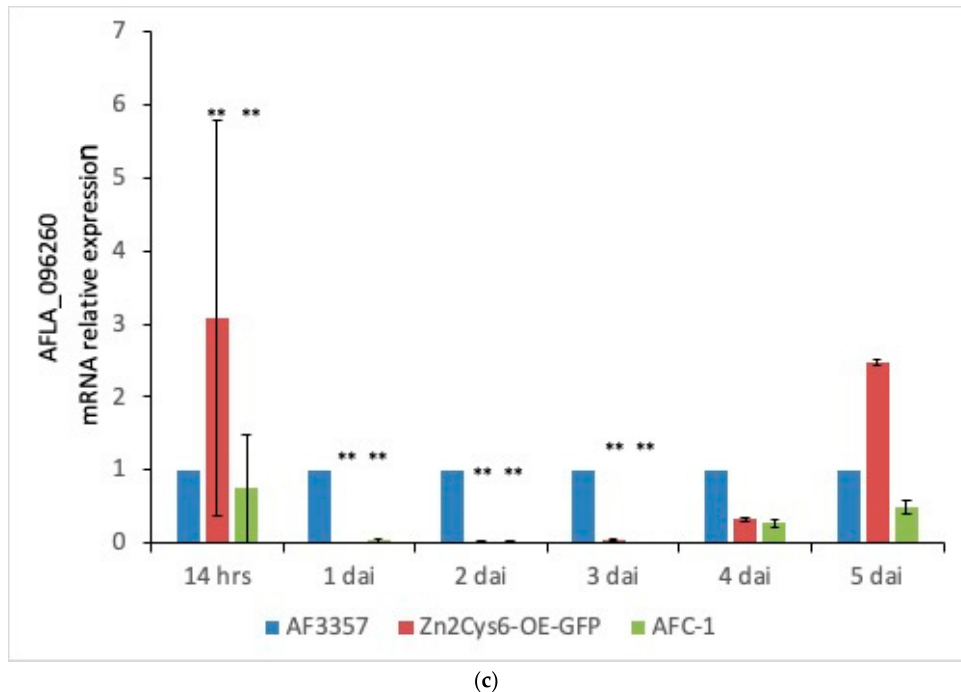
Figure 3. Relative expression of transcriptional levels for cluster 32 genes SalOH ( a ), npp1 ( b ) and AFLA_096260 ( c ) in fungal strains AF3357, Zn2Cys6-OE-GFP and AFC-1 from 14 hrs to 5 dai. Mean values and standard deviations were used to perform t -tests comparing Zn2Cys6-OE-GFP or AFC-1 to AF3357 (* p < 0.05; ** p < 0.01).